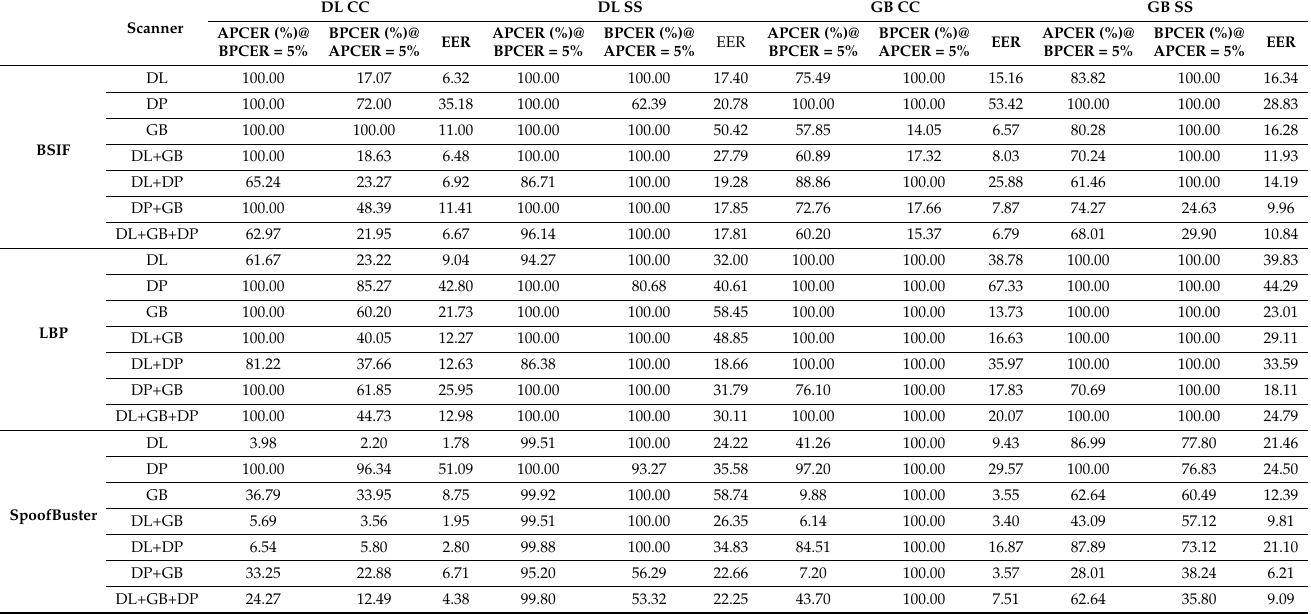
Table 10. Results in terms of accuracy, BPCER, and APCER at different operational points of BSIF, LBP, and SpoofBuster PADs with different single-sensor and multi-sensor training techniques for LivDet 2021